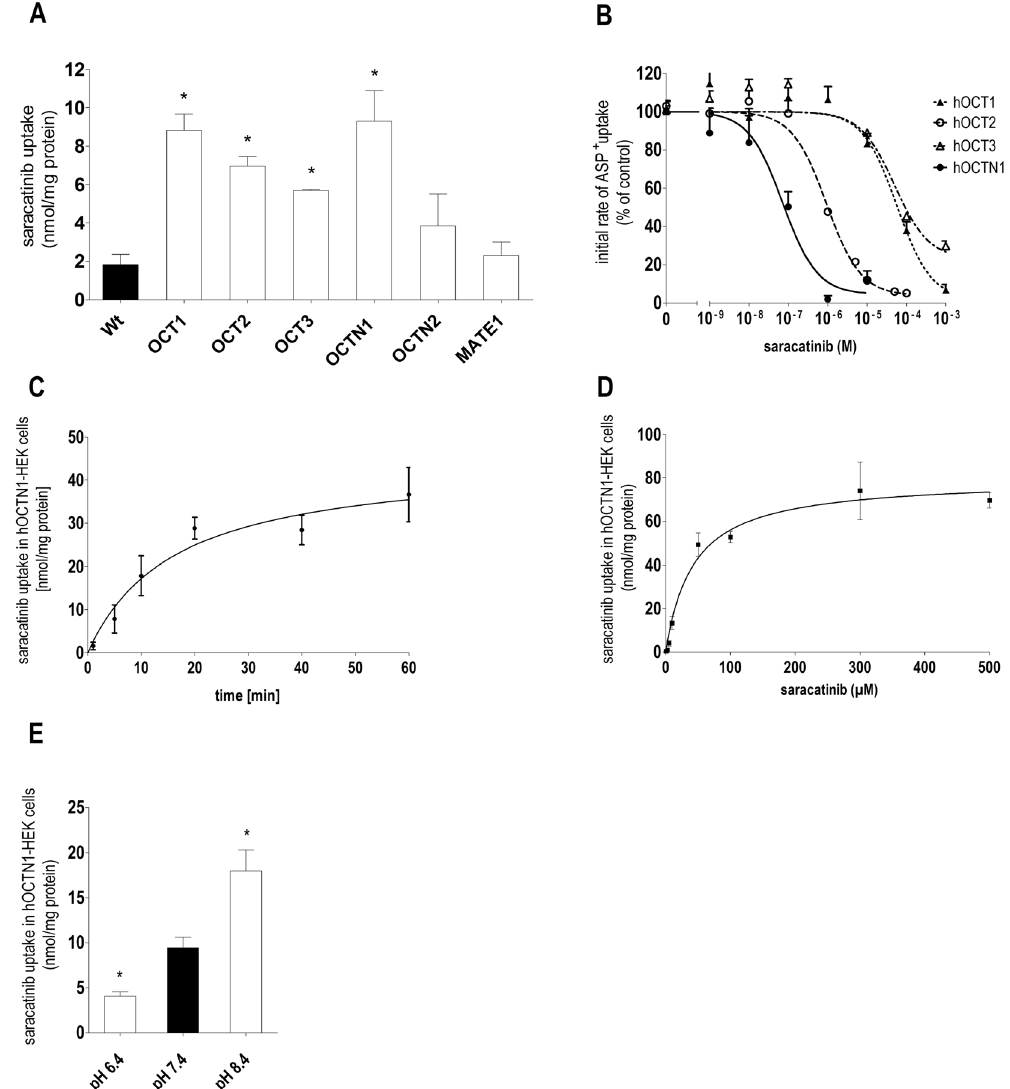
Figure 1. Characteristics of saracatinib uptake in HEK293 cells stably transfected with transporters of organic cations. ( A ) Specific saracatinib uptake by HEK293 cells overexpressing hOCT1-3, hOCTN1-2, and hMATE1 after 10 min incubation with saracatinib (10 µ M) given as difference of accumulation at 4 °C and at 37 °C measured by the HPLC-UV method (n = 5–9). ( B ) Inhibition of initial ASP + uptake in HEK293 cells overexpressing hOCT1 ( ▴ ), hOCT2 ( ⚬ ), hOCT3 ( ▵ ) or hOCTN1 ( ⦁ ) by increasing saracatinib concentrations. Values are mean ± SEM expressed as percentage of ASP + uptake in the absence of saracatinib (n = 12–18). ( C ) Time-dependent saracatinib uptake by hOCTN1-HEK293 cells using a fixed concentration of 10 µ M (n = 3). ( D ) Concentration-dependent uptake of saracatinib by hOCTN1- HEK293 cells (n = 12) after 10 min incubation, based on linearity of uptake determined from time-dependent saracatinib uptake studies (s. 1 C). ( E ) Influence of extracellular pH on saracatinib accumulation into hOCTN1-HEK293 cells (n = 12).